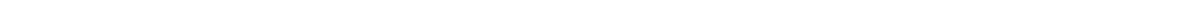
Fig. 6 Hira is crucial for the role of H3.3 in reprogramming. a Schematics of the H3.3 knockdown ATAC-Seq experiment (top). Venn diagram revealing the number of uniquely and commonly accessible regions in cells in which H3.3 was knocked-down. The pie charts demonstrate the genomic distribution of the accessible regions. b Bar chart demonstrating the hypergeometric test performed on loci with signi fi cant accessibility changes. Y -axis denotes the percentage of regions in each category. * p -value <0.05. ** p -value >0.1 using Benjamini – Hochberg statistics. c Schematics of the early time-point knockdown experiment (top). The bar chart below represents the number of colonies ( y -axis) observed in wells in which the knockdown of the indicated genes had been performed. Non-targeting siRNA constructs were used as controls (siNT). Values are mean ± s.e.m from independent replicate experiments ( n = 3). Two-tailed t -test was used for statistical analysis. Error bars represent standard deviation. Representative images of the wells in which the counting took place (top). d Schematics of the late time-point knockdown experiment (top). The bar chart below represents the number of colonies ( y - axis) observed in wells in which the knockdown of the indicated genes had been performed. Non-targeting siRNA constructs were used as controls (siNT). Values are mean ± s.e.m from independent replicate experiments ( n = 3). Two-tailed t -test was used for statistical analysis. Error bars represent standard deviation. Representative images of the wells in which the counting took place (top). e Enrichment of motifs in the indicated intergenic regions. Enrichment ranges from not enriched (white) to highly enriched (dark red). f Schematics of the overexpression experiment (top). The bar chart below represents the number of GFP + colonies ( y -axis) observed in wells in which the overexpression of the indicated constructs ( x -axis). Cells overexpressed with empty vectors were used as controls. Values are mean ± s.e.m from three independent replicate experiments. Two-tailed t -test was used for statistical analysis. Error bars represent standard deviation. Representative images of the wells in which the counting took place (top). g Dynamic enrichment of H3.3 (left), H3K4me3 (middle) and H3K36me3 (right) over fi broblast genes. Colour ranges from dark blue (low enrichment) to dark red (high